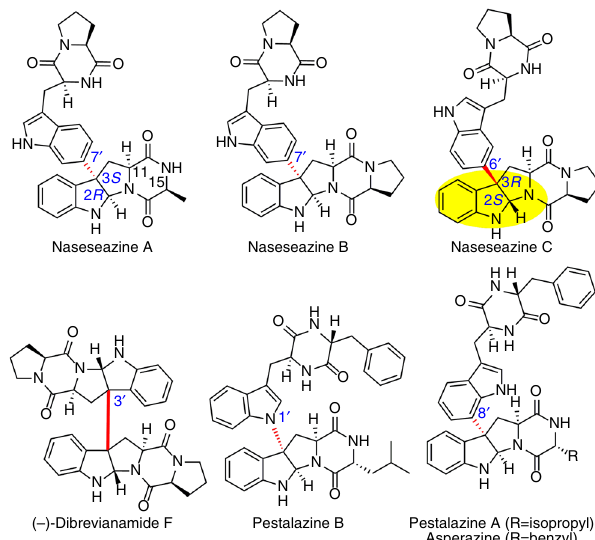
Fig. 1 The structures of some naturally occurring C 3 -aryl pyrroloindolines. Highlighted in nasseazine C is pyrroloindoline motif featuring 2 S -3 R chirality and C 3 – C 6 ′ bond connectivity. Other types of C 3 -aryl connectivity are highlighted with a red